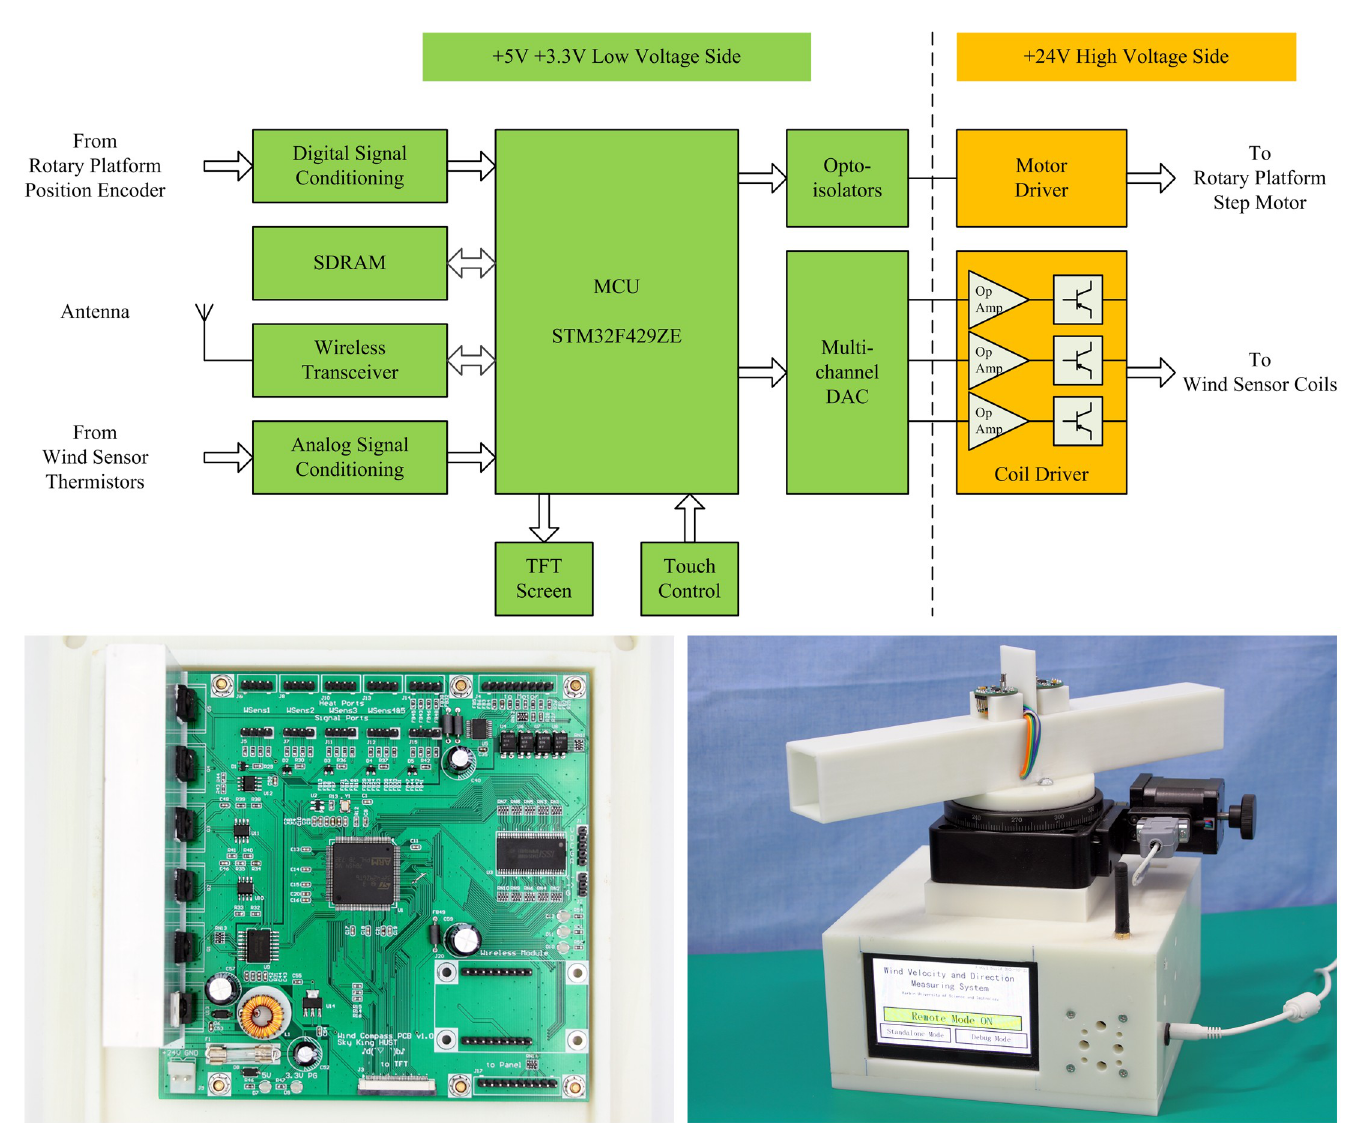
Fig 9. Wind velocity and direction measurement instrument. (A) System block diagram (B) PCB (C) Instrument.